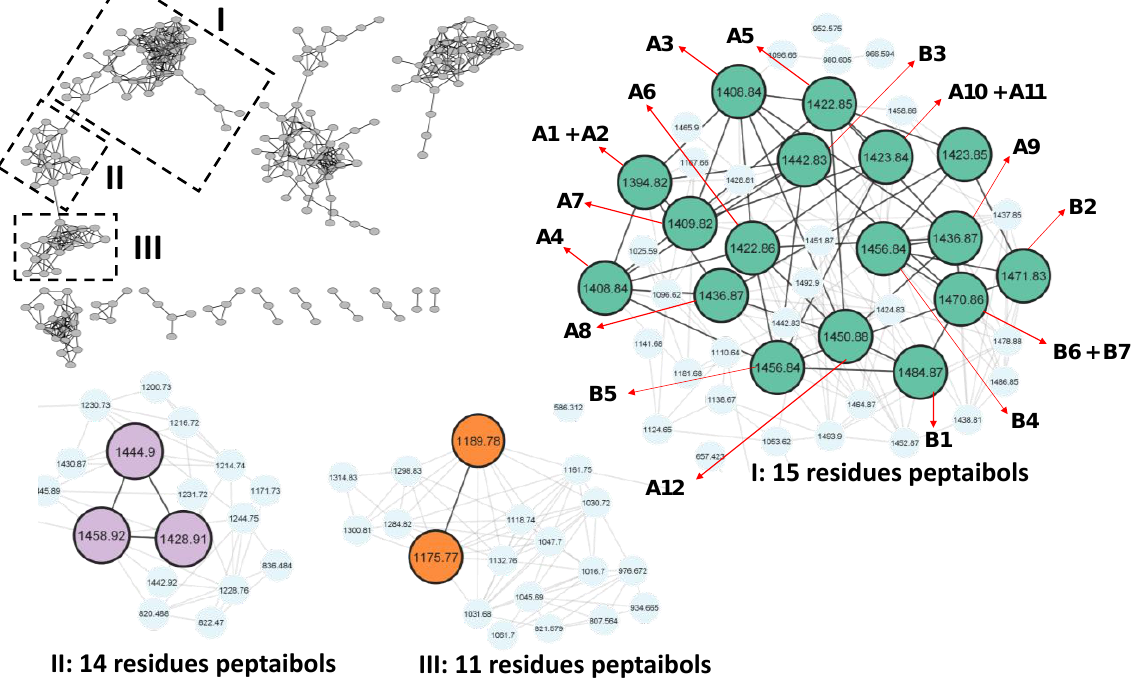
Figure 5. Annotation of the molecular network of peptaibols derived from the ethyl acetate extract. Green nodes: putative sequences of 15-res. Lilac nodes: peptaibols of 14-res. Orange nodes: peptaibols of 11-res.